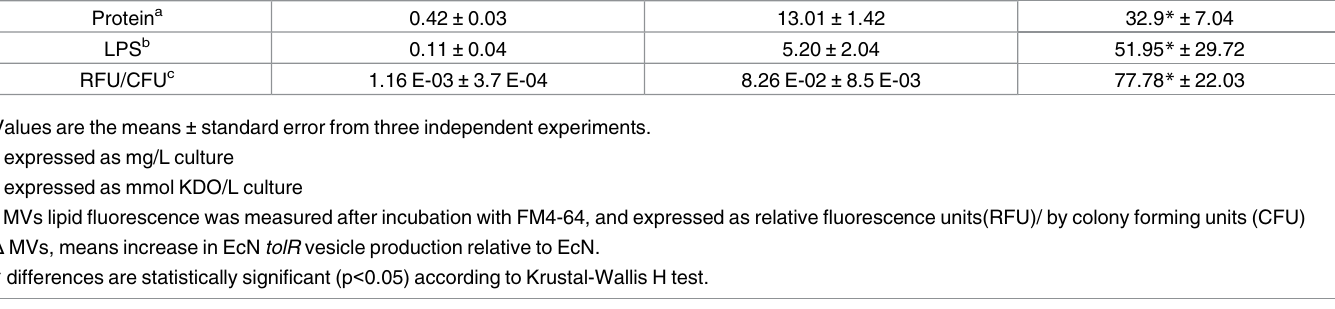
Table 1. MV production of EcN and EcN tolR strains determined by three methods. Protein